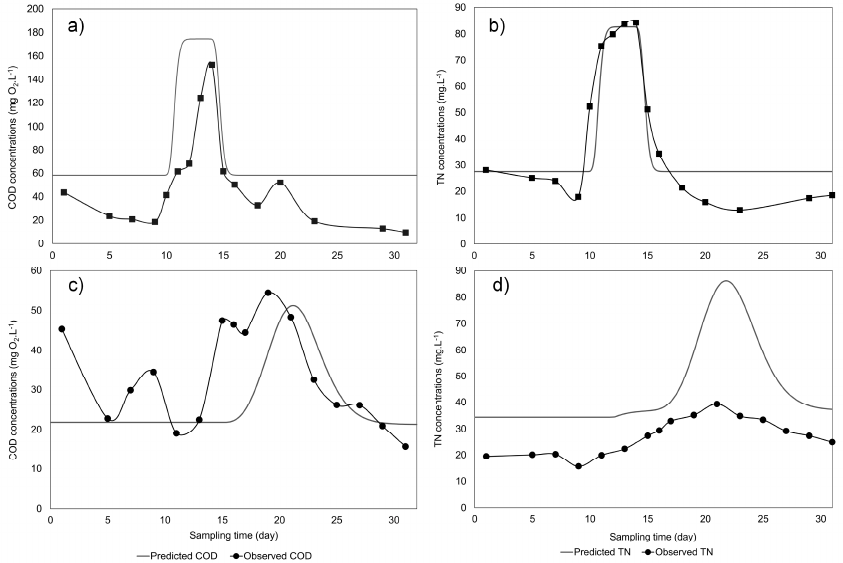
Figure 5. Predicted and observed effluent pollutant levels of conventional activated sludge (( a ) and ( b )) and waste stabilization pond (( c ) and ( d )) systems during the shock load scenario.